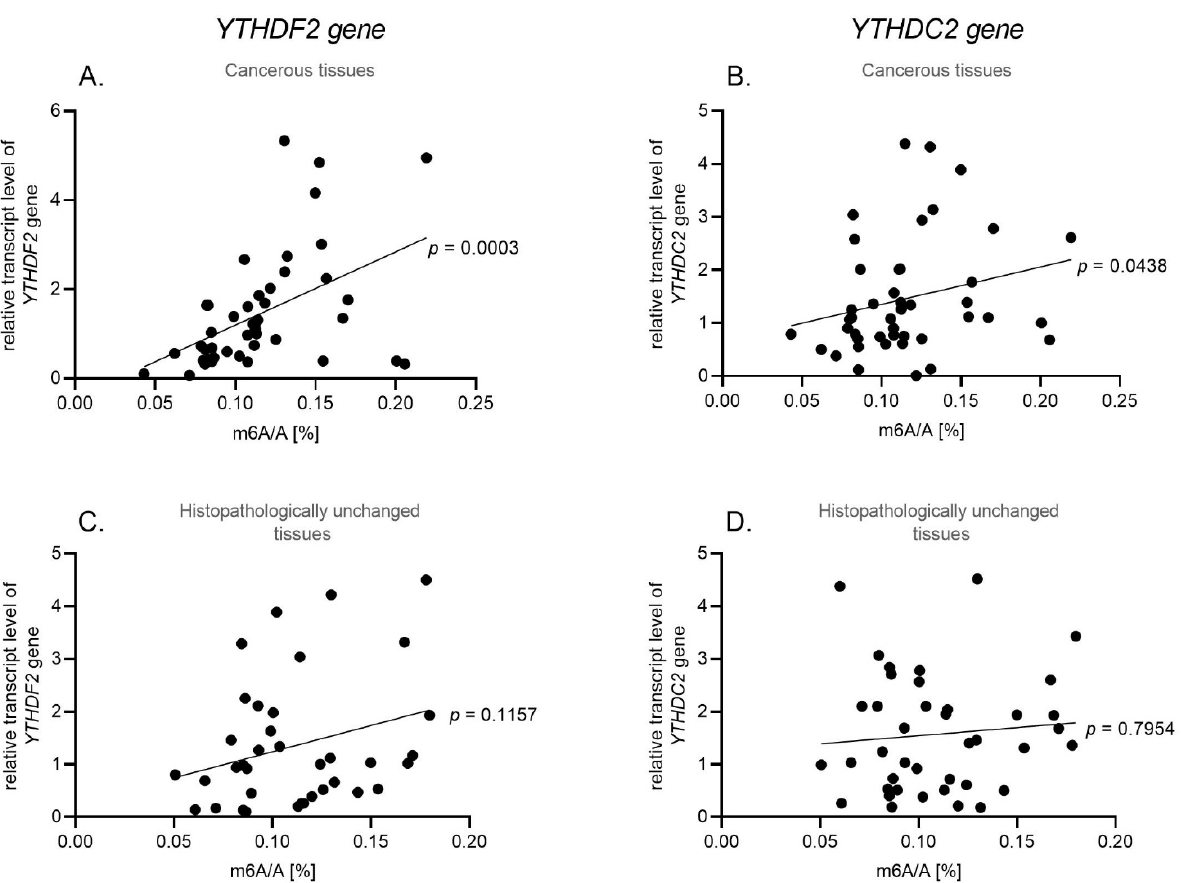
Figure 5. Spearman correlation of m 6 A/A [%] and YTHDF2 and YTHDC2 mRNA level in cancerous tissues ( A , B ) and histopathologically unchanged tissues ( C , D ).